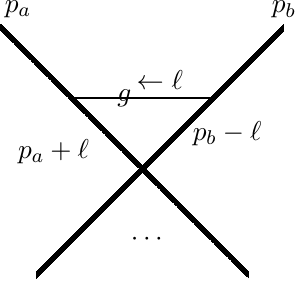
Figure 7 . Diagram contributing to (cid:0) ( n ) .